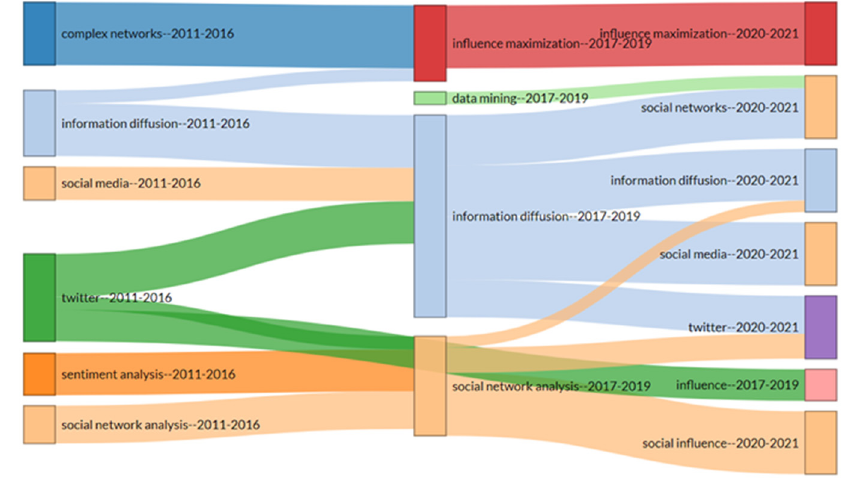
Figure 6. Thematic evolution for Dataset 1.